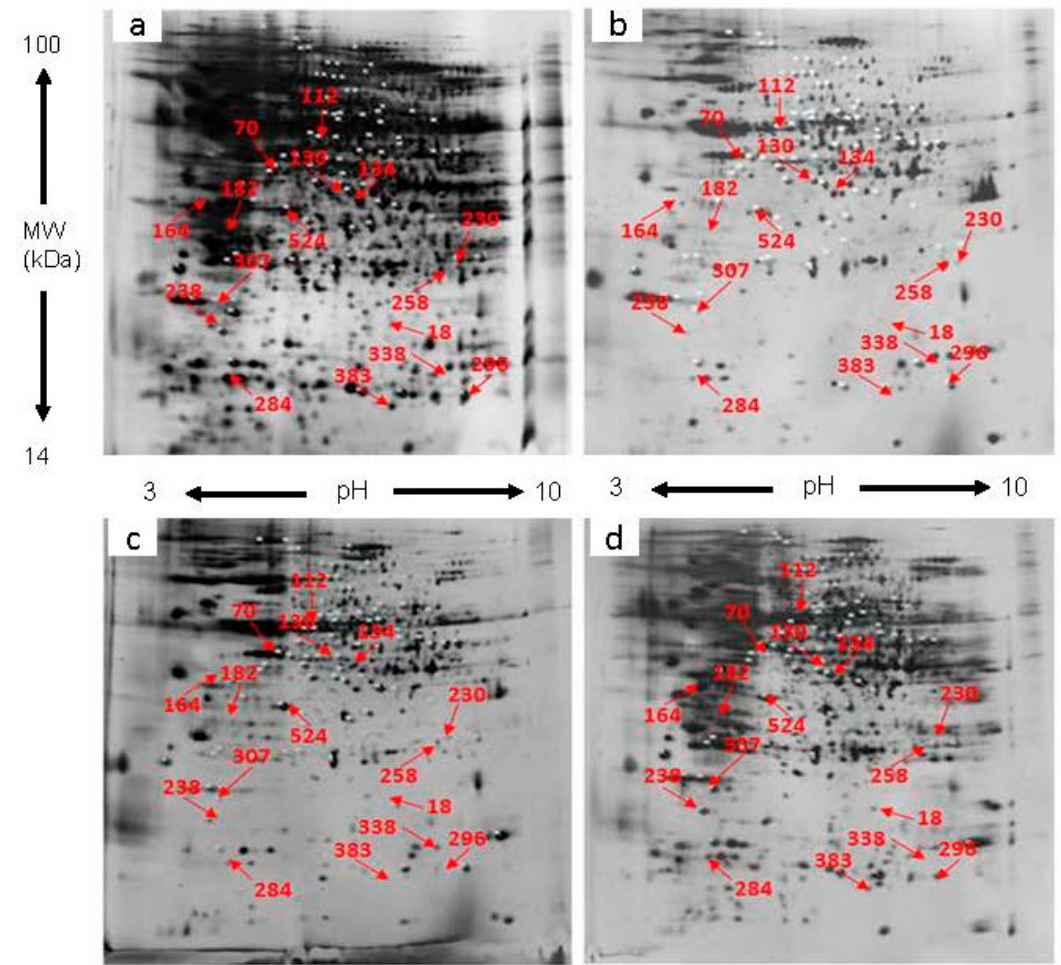
Figure 2. Representative 2-DE gel images of pistil protein profiles of D. chrysanthum . ( a , b ) 2-DE gel images of SP pistils protein profiles at 2 h and 4 h post-pollination, left and right images, respectively; ( c , d ) 2-DE gel images of CP pistils protein profiles at 2 h and 4 h post-pollination, left and right images, respectively. Some of the selected protein spots are demonstrated with red arrows.